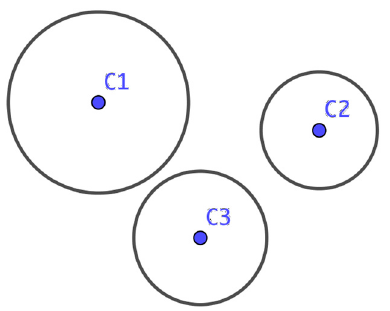
Figure 11. How to draw tangent circles to three given circles .